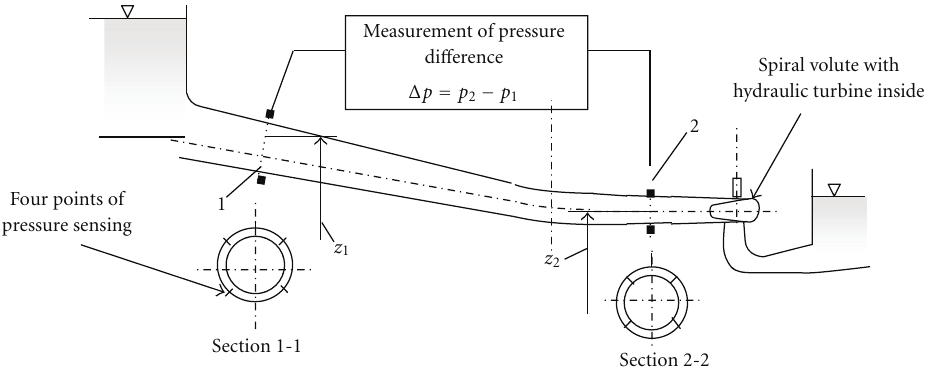
Figure 1: Penstock and measuring sections in Gibson’s